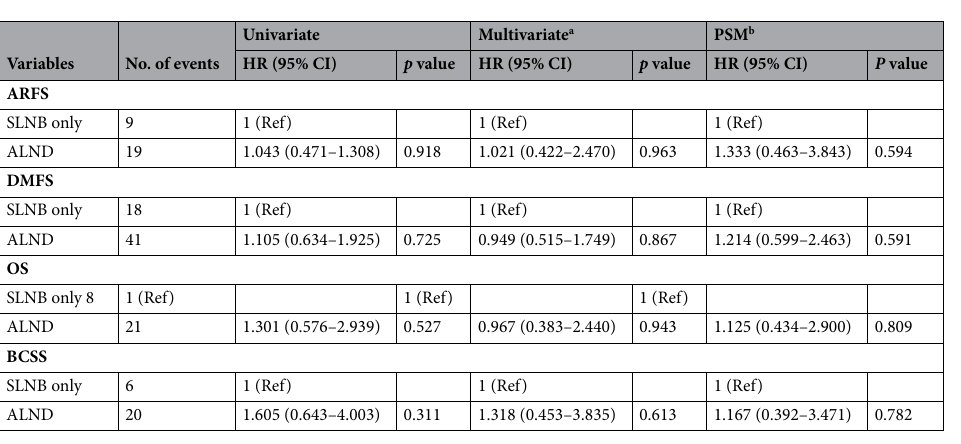
Table 4. Cox regression analysis of ARFS, DMFS, OS, and BCSS. a Adjusted for variables listed in the Table 1. b Column PSM is the result of a univariate analysis after propensity matching. ARFS, axillary recurrence-free survival; DMFS, distant metastasis-free survival; OS, overall survival; BCSS, breast cancer-specific survival; SLNB, sentinel lymph node biopsy; ALND, axillary lymph node